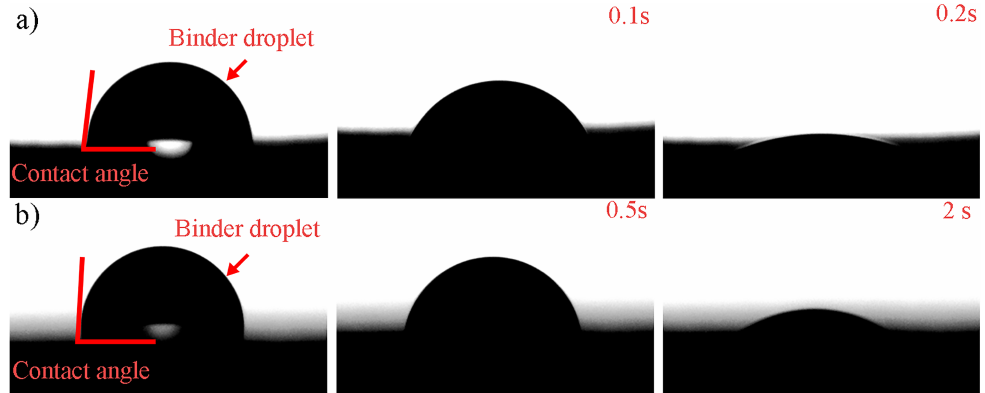
Figure 3. The contact angles of droplets on the surfaces of pure and mixed powders were measured. ( a ) The droplet of binder on the surface of pure powder; ( b ) the droplet of binder on the surface of mixed